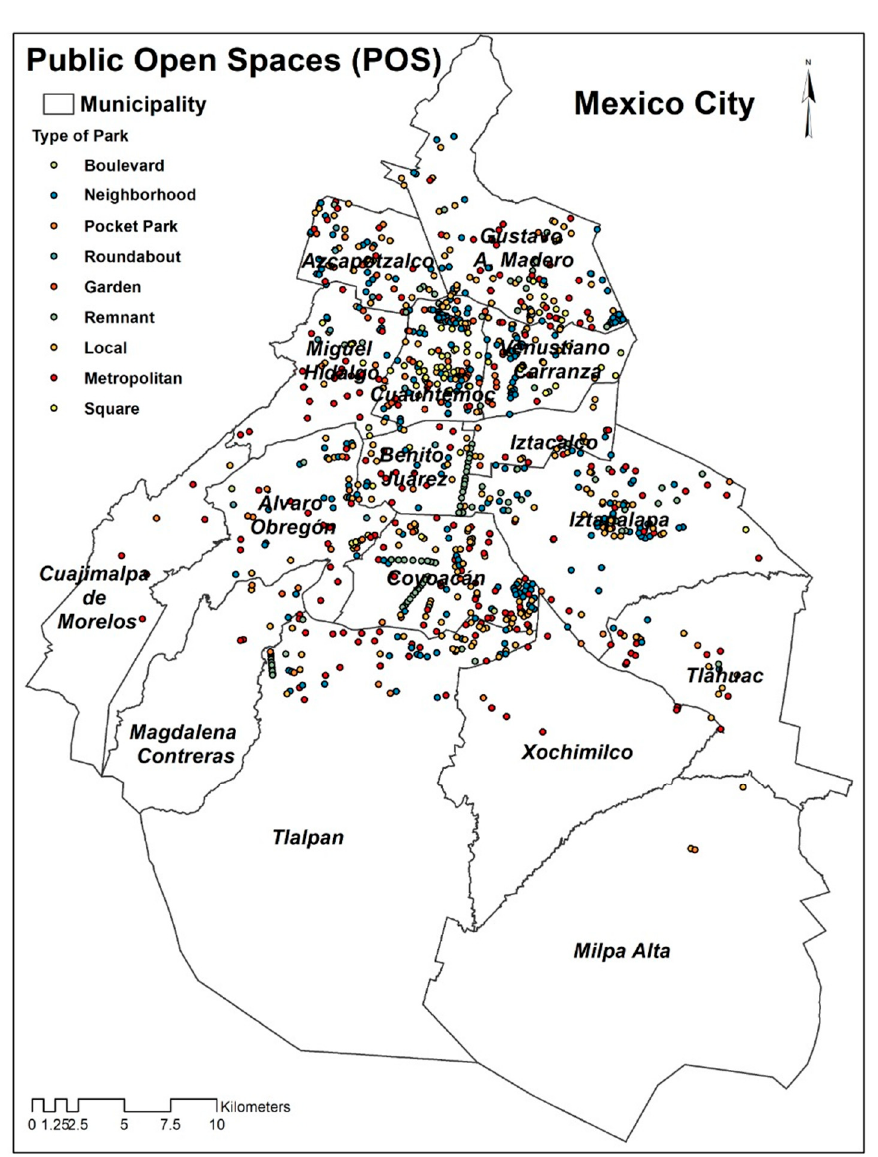
Figure 1. Distribution of POS according to municipality and typology.